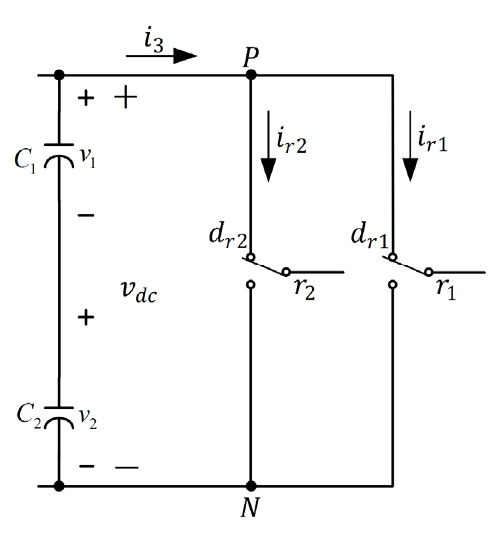
Figure 9. Equivalent circuit of the three-phase, six-leg inverter